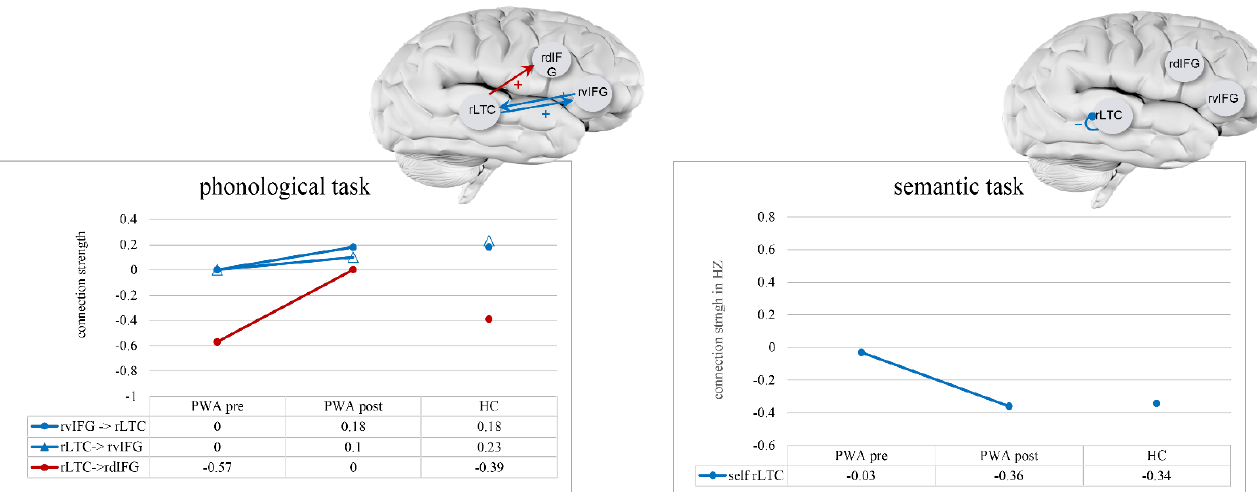
Figure 3. Connections that changed during treatment in patients with aphasia (PWA) and remained stable in healthy controls (HC) in the phonological ( a ) and semantic ( b ) tasks. Connection strength (in Hz for extrinsic connection and in unitless log-scaling for intrinsic connection) are depicted on the Y-axis and in the table, for pre- and post-treatment for PWA and as the average across time points in HC. Blue indicates the average across all trials with objects (A matrix), and red indicates the modulation of the phonological or semantic conditions (B matrix). A plus sign (+) indicates increased excitation; a minus sign ( − ) in the self-connection indicates decreased inhibition.